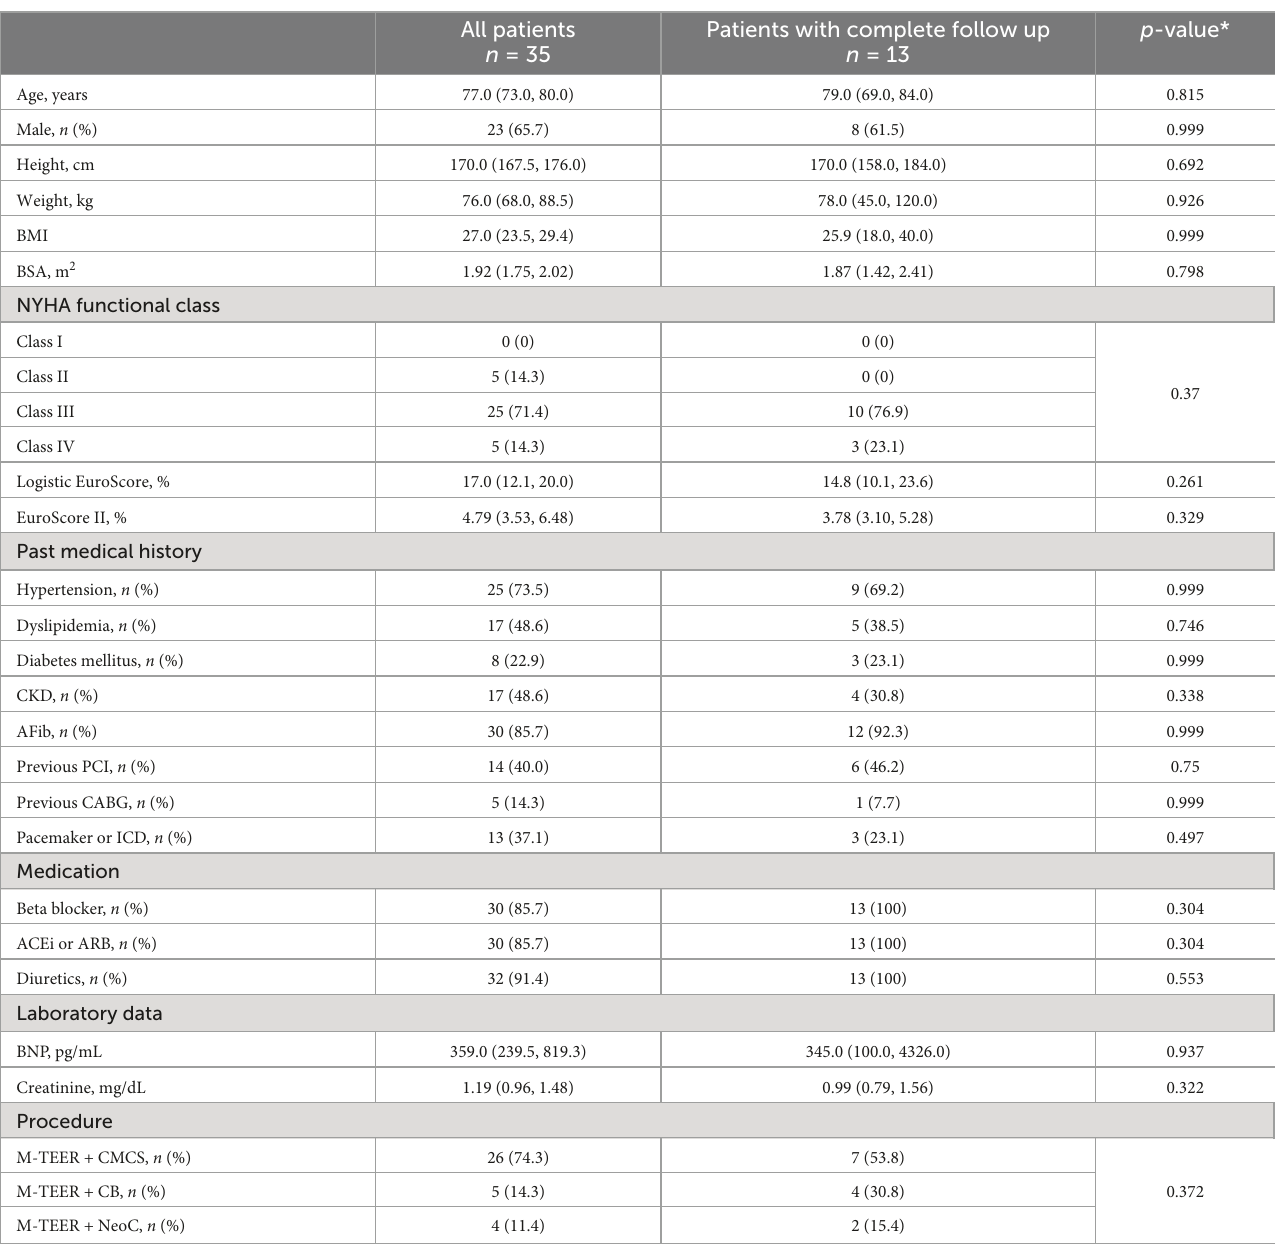
TABLE 1 Baseline characteristics.